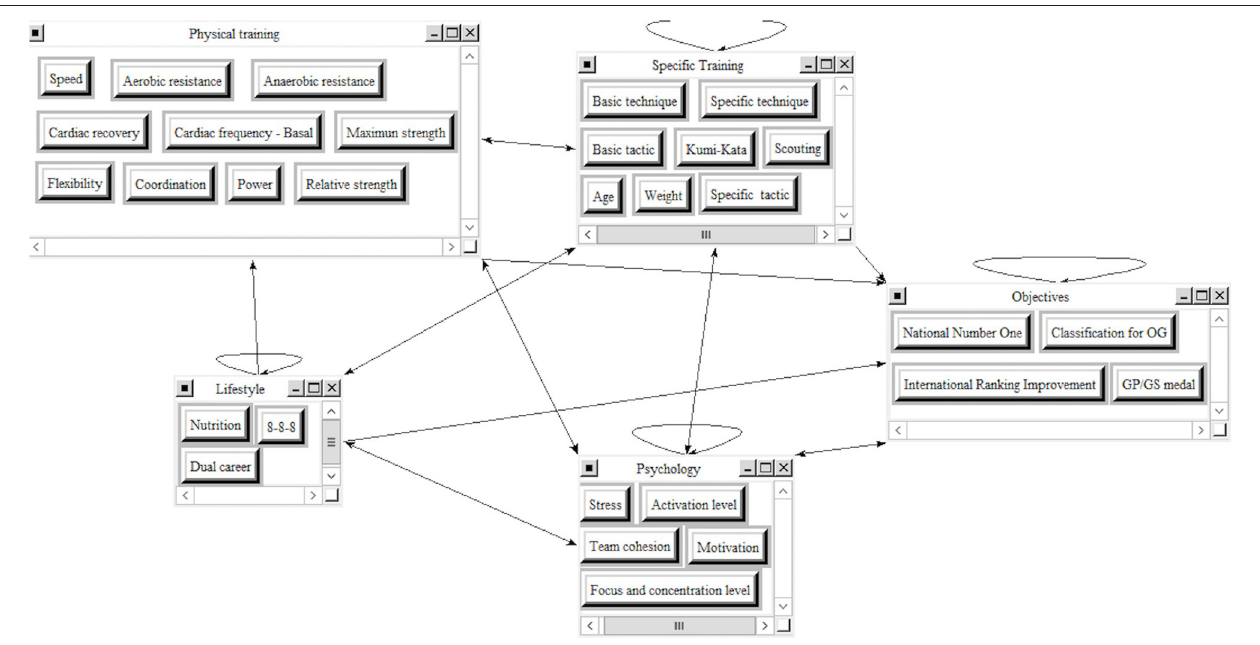
FIGURE 2 | ANP influence model in Superdecisions